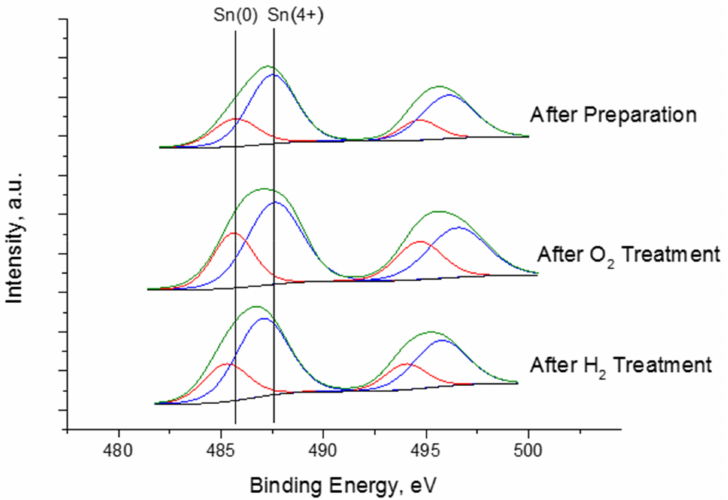
Figure 9. XPS spectra of the Sn 3d 5/2 core-level after various steps of heat treatment of the 1Pd1Sn/ γ - Al 2 O 3 sample: after preparation procedure (deposition of the metallic precursors), after oxidation treatment in O 2 atmosphere at 350 ◦ C for 2 h and after reduction in H 2 atmosphere at 500 ◦ C for 2 h.